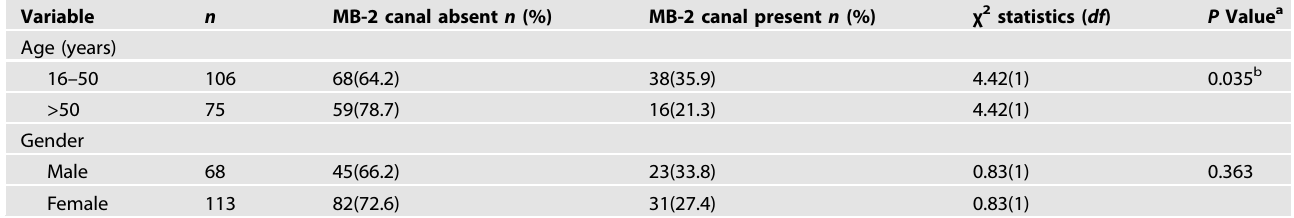
Table 3. Association of the presence of MB-2 canals in maxillary second molars by gender, and age groups ( n = 181). Variable n MB-2 canal absent n